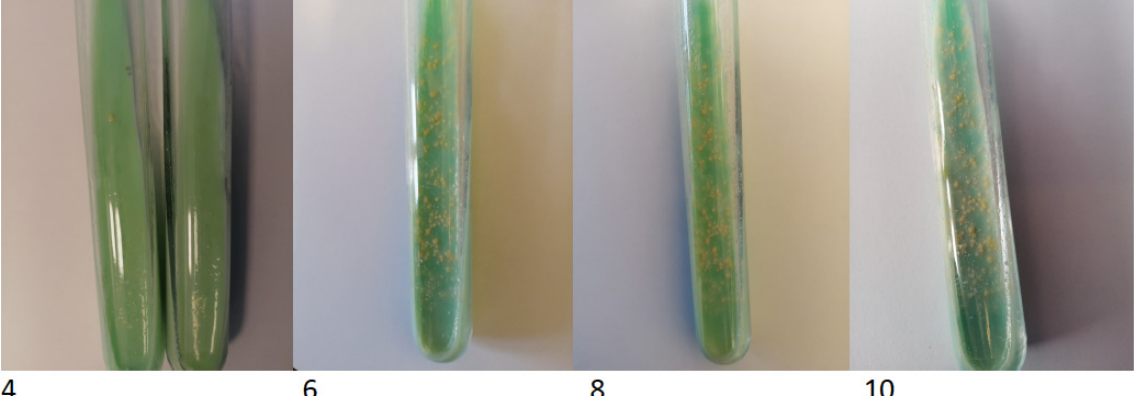
Figure 5. The colony growth on Löewenstein-Jensen solid medium on the 4th, 6th, 8th and 10th day of incubation.